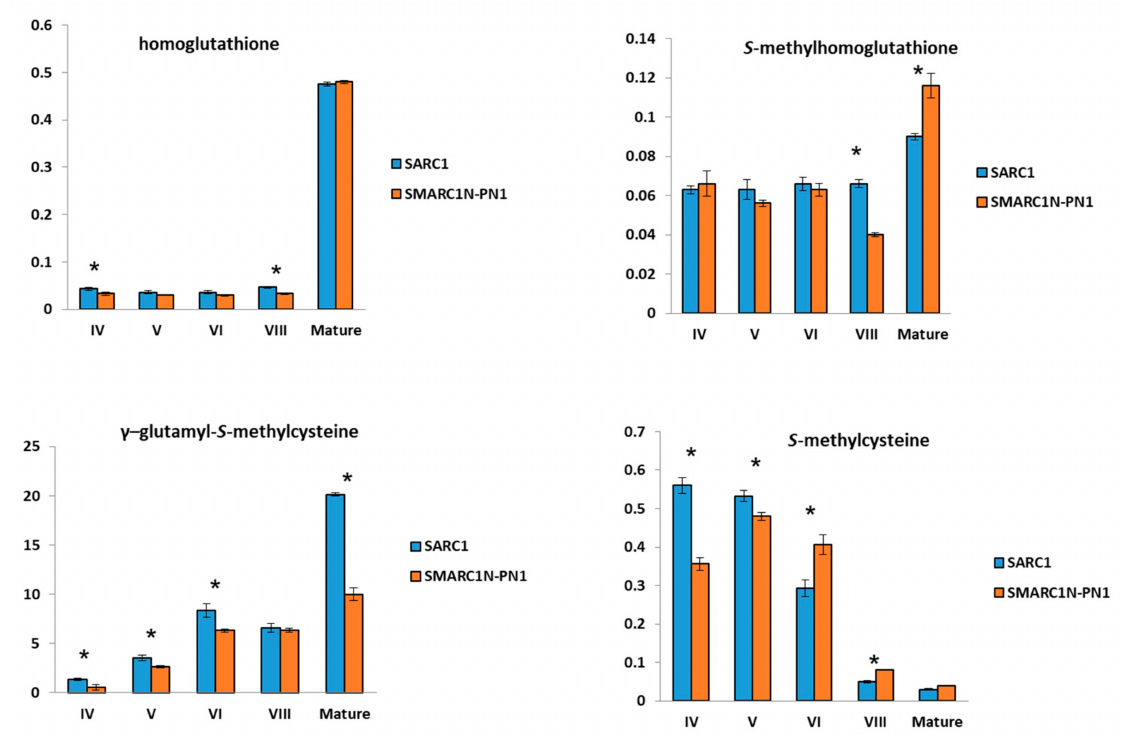
Figure 2. Quantification of sulfur metabolites at di ff erent developmental stages in SARC1 and SMARC1N-PN1. Concentration is expressed in nmol per mg seed weight; average ± standard deviation; n = 3. Asterisks indicate significant di ff erences at t -test p value ≤ 0.01. n =